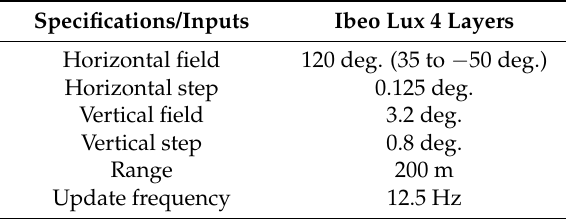
Table 1. Sensor model configuration. Virtual CPS sensor specifications (inputs to